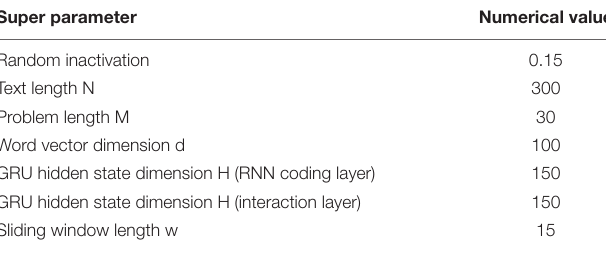
TABLE 4 | Baseline model